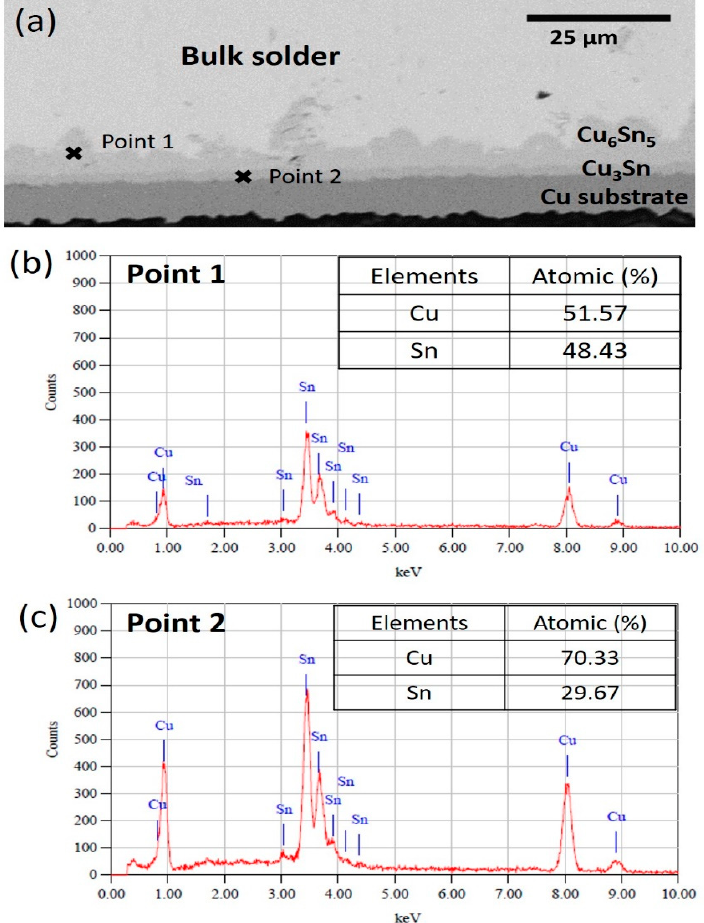
Figure 10. ( a ) Cross-sectional images of EDX point analysis. ( b ) EDX analysis result at point 1 and ( c ) EDX analysis result at point 2.